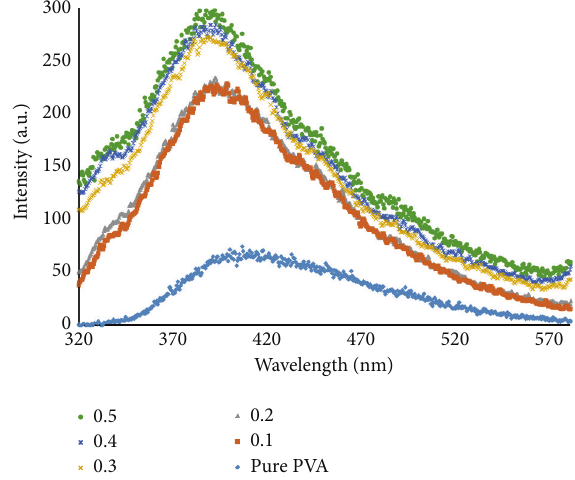
Figure 4: PL spectra of pure PVA and PPVA films with five mole ratios (0.1, 0.2, 0.3, 0.4, and 0.5) at an excitation wavelength of 300 nm.